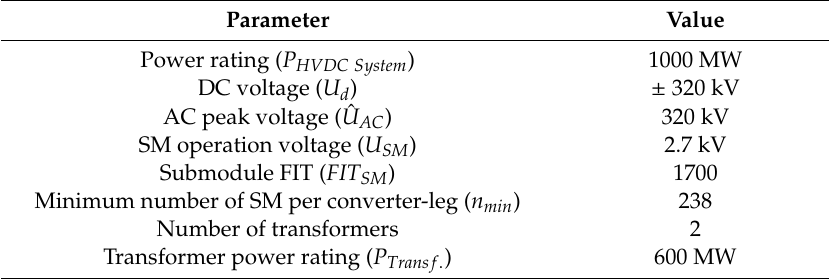
Table 1. Energy export system technical